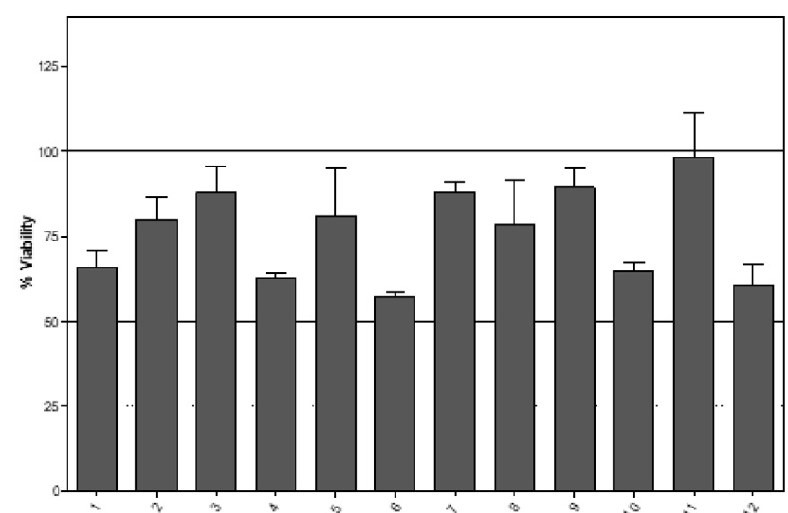
Figure 8 . Percentage parasite (Plasmodium falciparum strain 3D7) viability ± SD obtained for compounds 1 – 12 .